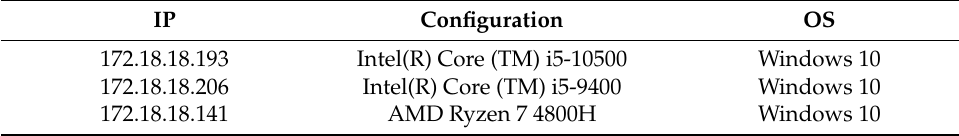
Table 3. Configurations of the three laptops.